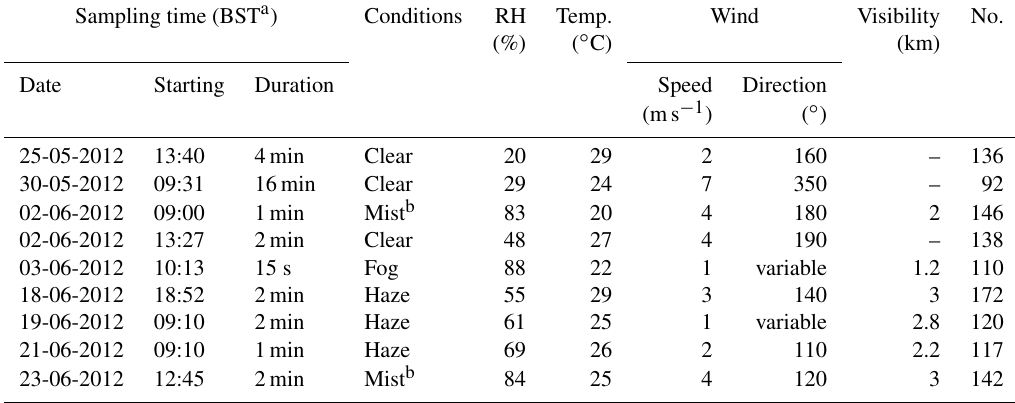
Table 1. Sampling time and instantaneous meteorological state. Sampling time (BST a